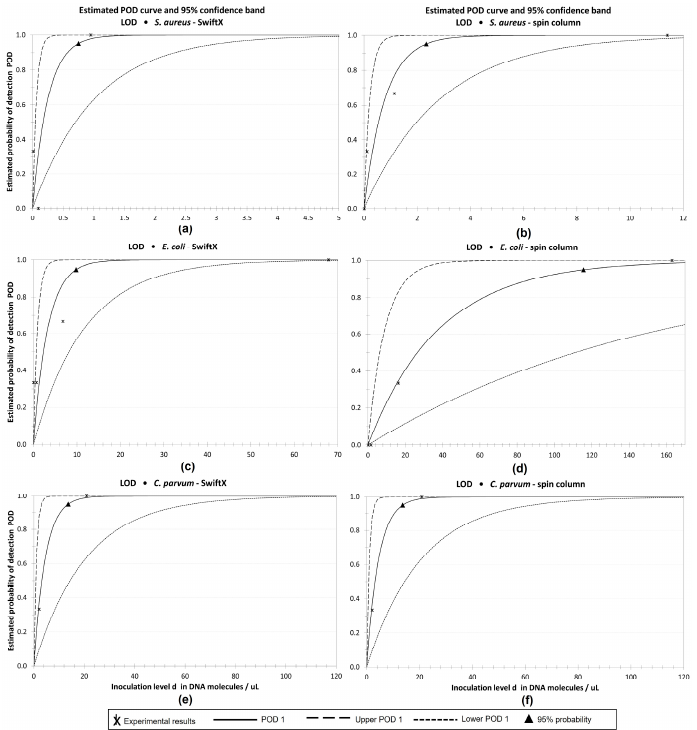
Figure 6. Probability of detection of method of choice for the extraction of S. aureus ( a , b ), E. coli ( c , d ) and C. parvum ( e , f ). Between 10 3 and 10 6 bacterial cells or oocysts per microliter were spiked into wastewater in a ten-fold serial dilution. In the case of S. aureus and E. coli , DNA was extracted using SwiftX in combination with proteinase K and bead beating. For C. parvum , the SwiftX protocol was combined in a preincubation with pro- teinase K. The e ffi ciency of the extraction protocols was compared to a spin column ref- erence method. The probability of the detection function was calculated by the Wilrich and Wilrich model using quanti fi cation cycles measured by real-time PCR. The 95% probability is depicted as a triangle. For S. aureus , 0.74 copies per reaction with SwiftX ( a ) and 2.33 with the spin column reference method ( b ) were calculated. For E. coli , 9.94 and 115.1 copies per reaction were measured for SwiftX ( c ) and the spin column refer- ence method ( d ), respectively. In the case of C. parvum , 13.55 copies per reaction were determined for both the SwiftX ( e ) and the spin column reference method ( f ).